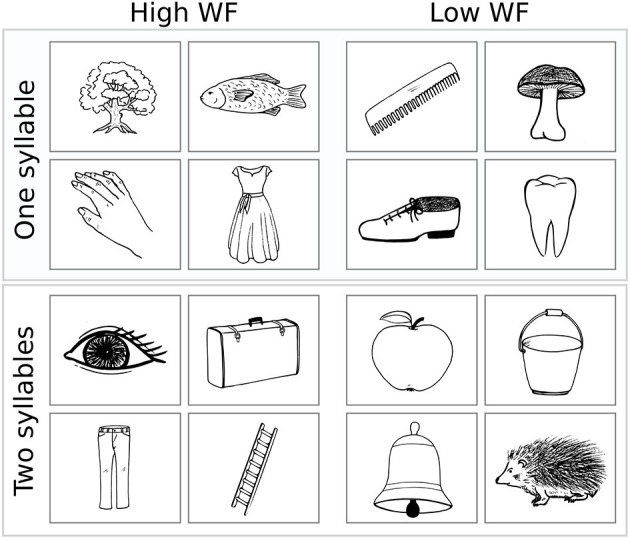
Example stimuli. Four example drawings are given for class A (upper left) to D (lower right). WF, Word frequency.